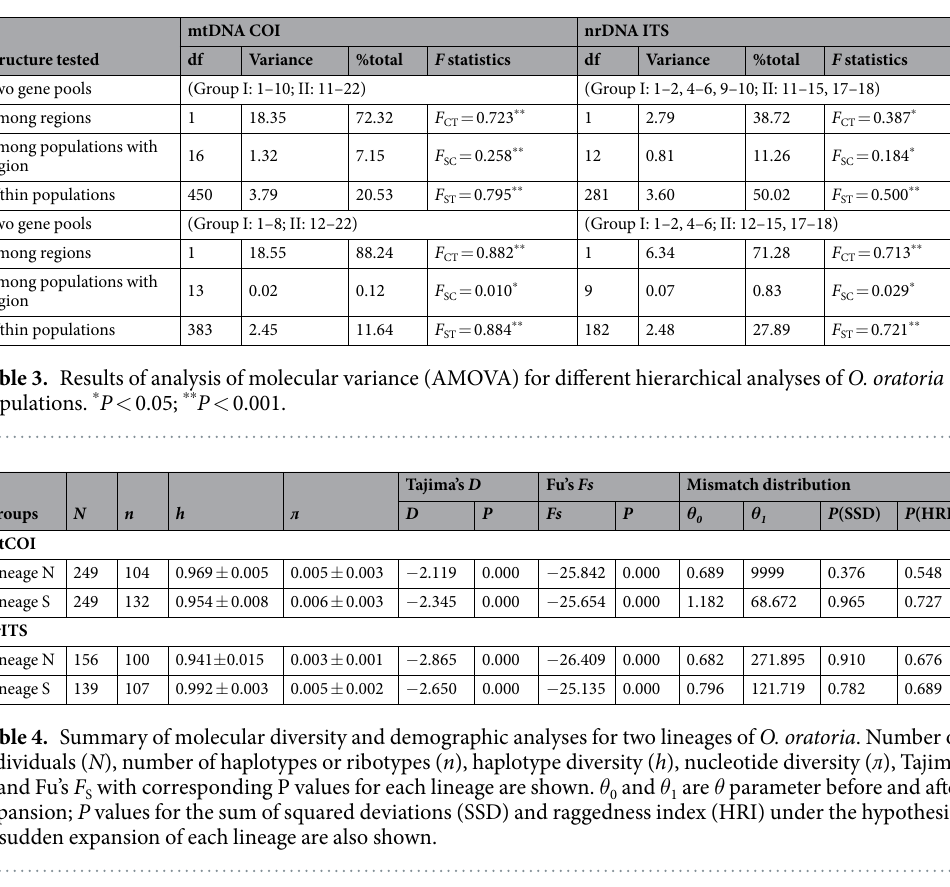
Historical demography. Tajima’s D and Fu’s F S calculated for each lineage were negative and statistically significant (Table 4), indicating recent demographic expansions. The sequential mismatch distributions of the two lineages (Fig. 3) and the permutation tests with the SSD and HRI statistics (Table 4) all suggested a unimodal distribution, providing further evidence of population expansion. BSP analysis indicated that two lineages have